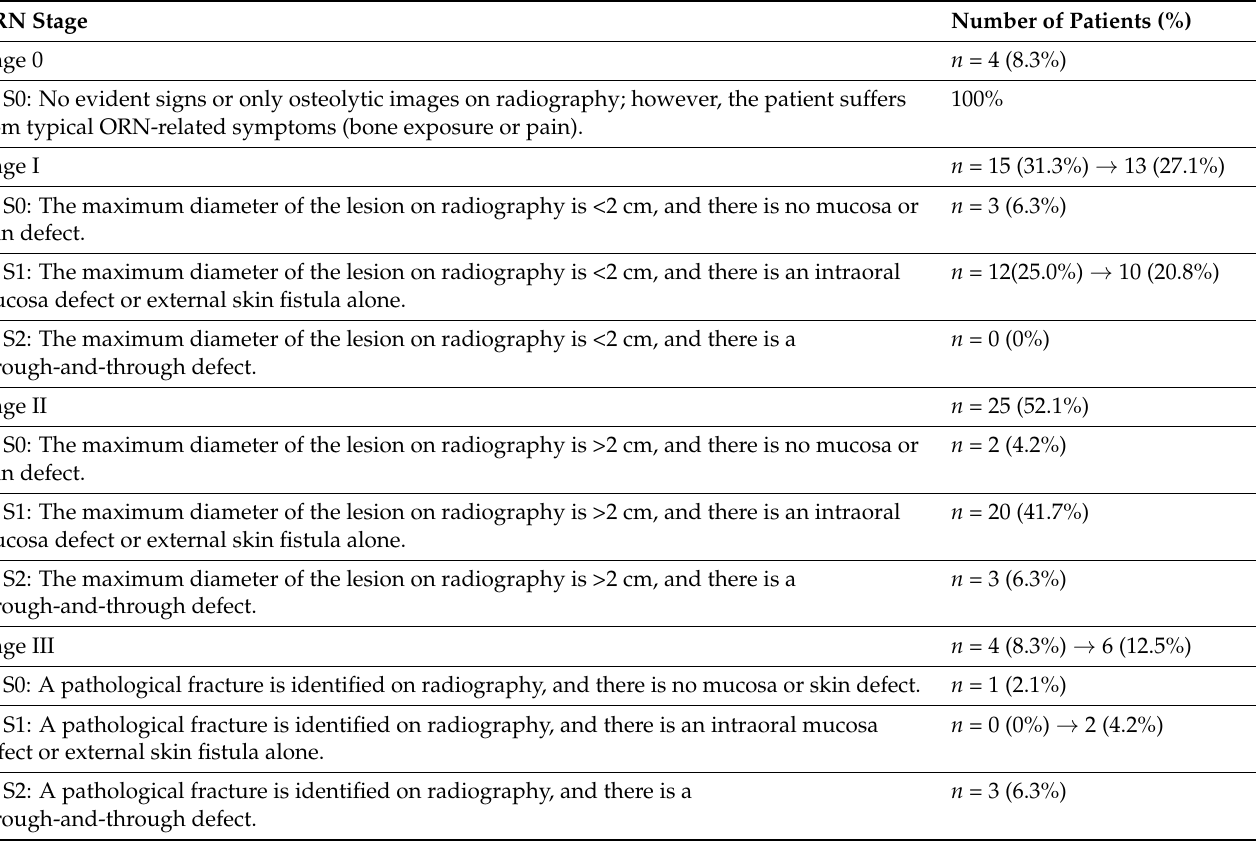
Table 2. Clinical classification of ORN by He et